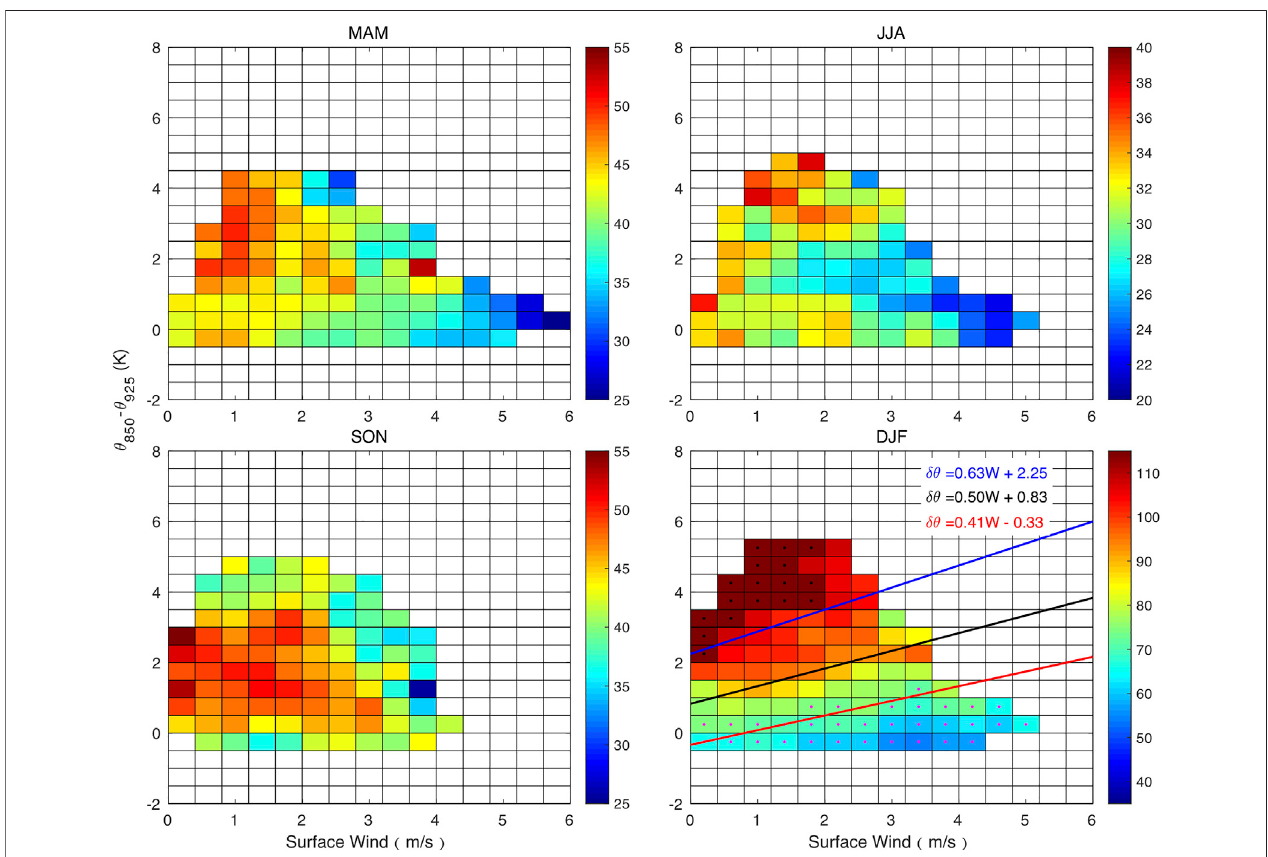
FIGURE 2 | Seasonal dependence of PM2.5 concentrations on the 10-m wind speed (Wind_10) and potential temperature difference between 925 hPa and 850 hPa ( Δ θ ) (unit of PM2.5 is μ g/m 3 ). The average PM2.5 concentrations are counted according to the observed Δ θ -Wind_10. All the available dry-day PM2.5 concentrations at the 64 stations are used in this fi gure. Grids with sample sizes greater than 100 are shown here. Dots in winter indicate the average PM2.5 concentration of the speci fi c grid higher than 115 (unhealthy level) or lower than 75 (moderate level) μ g/m 3 . The blue, black and red lines in winter indicate the thresholds for unfavorable conditions, air stagnation and favorable conditions, which are fi tted based on the locations of dots in Figures 2 , 3 ,